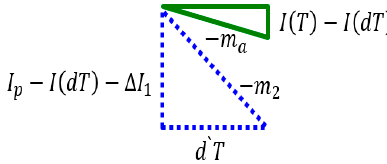
Figure 6. Comparison between ideal current and slope compensation.